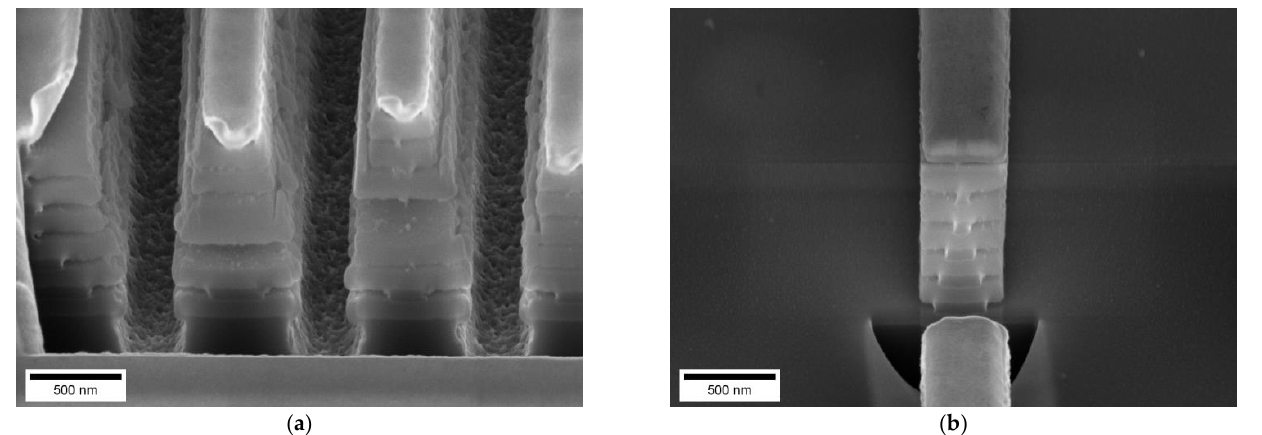
Figure 5. A multilevel underetched structure with a gold hard mask defined by electron beam lithography. ( a ) SEM image on the cross-section of the layer stack after etching. ( a ) Densely packed lines with little spacing. Lithographic structures are 400 nm (middle-left) and 350 nm (middle-right) wide. ( b ) Line with more than 1 µm inter-line-distance. The lithographic structure is 350 nm wide.